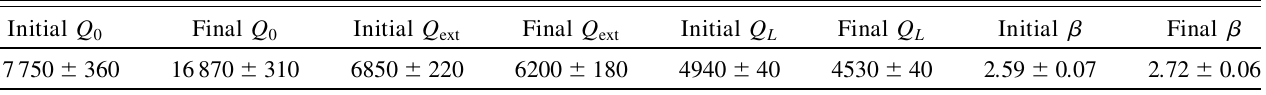
TABLE IX. Cavity Q measurements of TE mode of cavity 1 using a HP8510C network analyzer before and after the second 011 high-power test. The resonant frequency is 11.425 GHz. The errors are due to errors from fits to the data. Initial Q 0